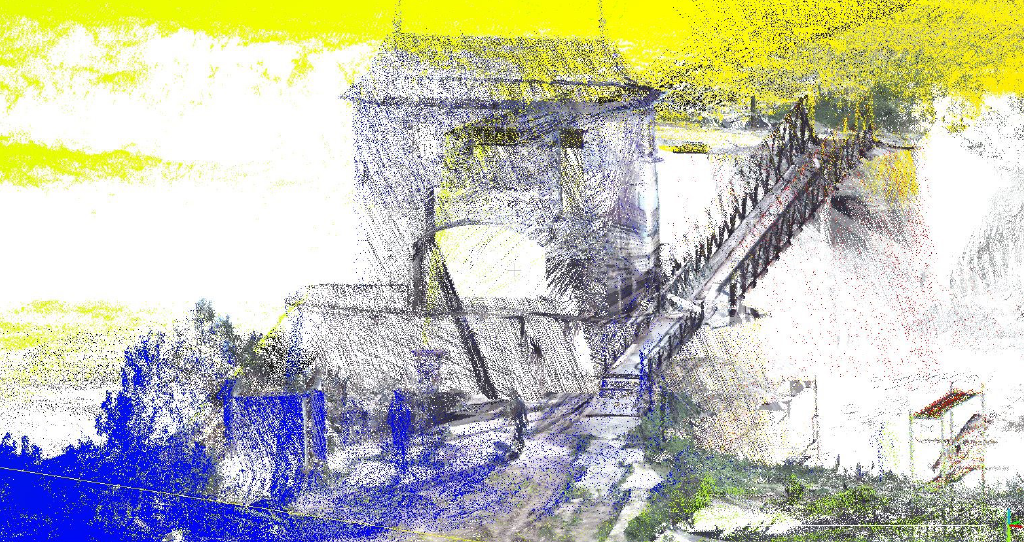
Figure 14. LiDAR data obtained by Velodyne VLP16 scanning at Sânmihaiu Român.